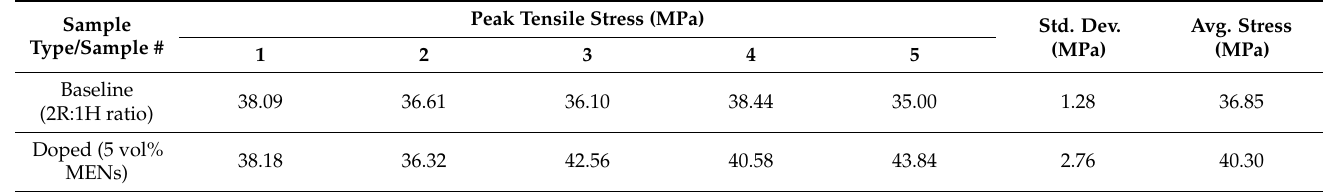
Table 1. Maximum tensile stress in undoped and doped adhesives with 5 vol%